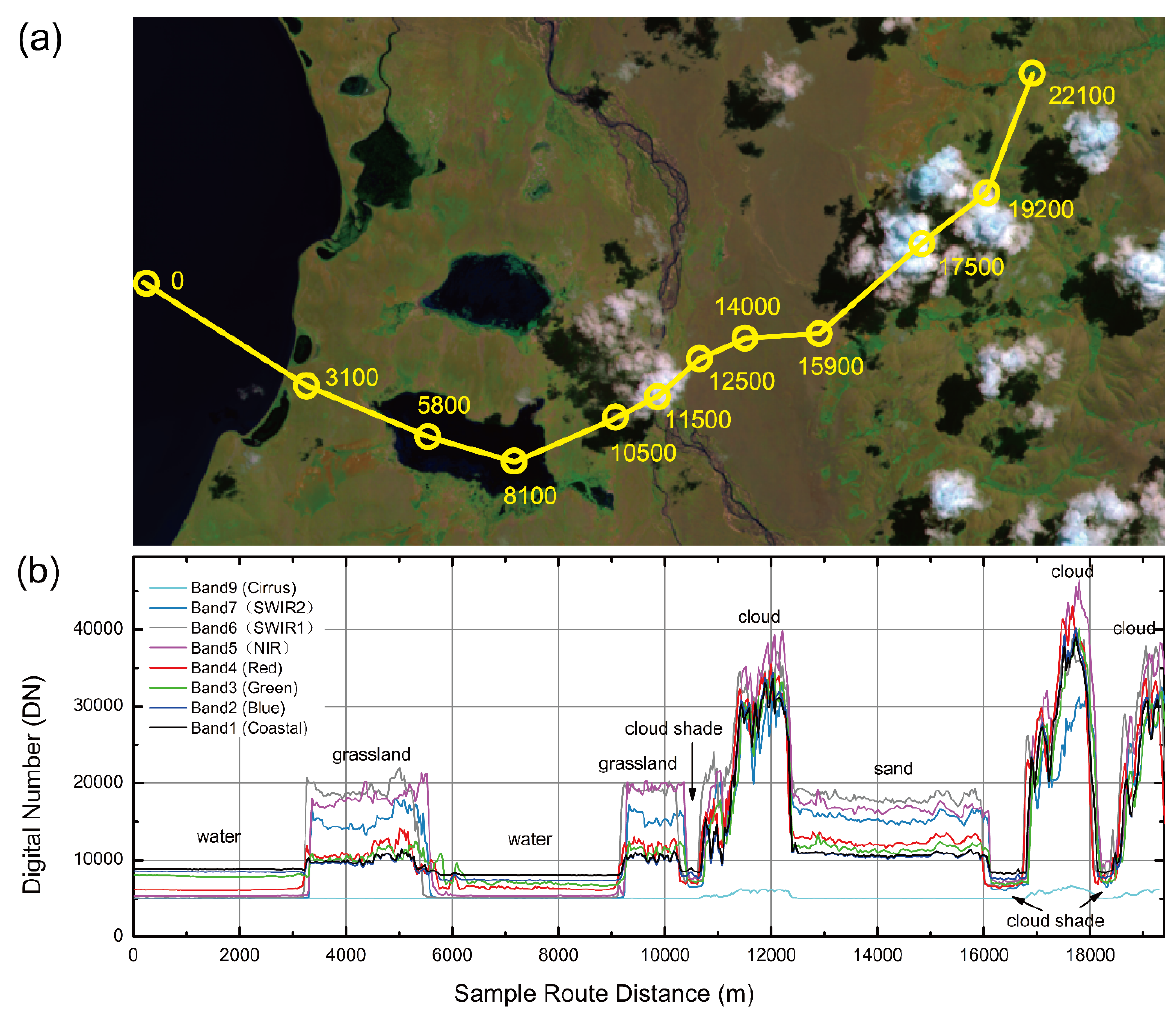
Figure 3. ( a ) Bands 7, 5, and 3 pseudocolor synthetic images and spectral sampling routes; ( b ) Digital number (DN) along with sampling route.